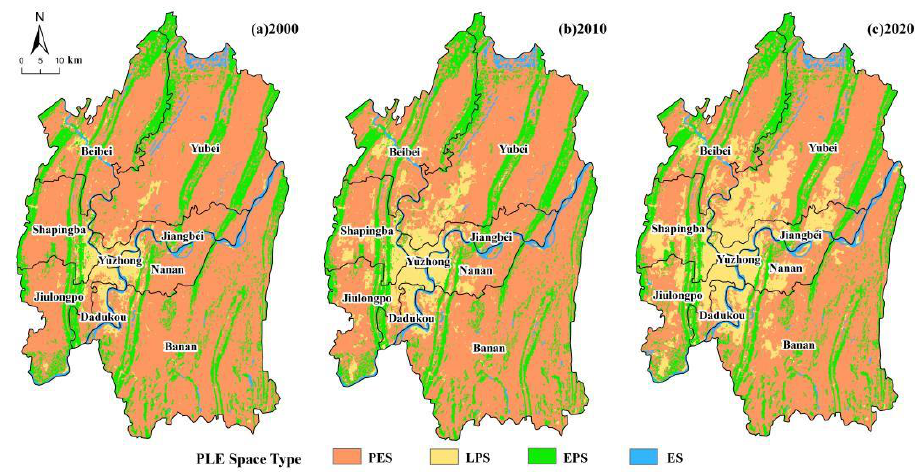
Figure 3. Spatial – temporal evolution of the PLES from 2000 to 2020. Figure 3. Spatial-temporal evolution of the PLES from 2000 to 2020.